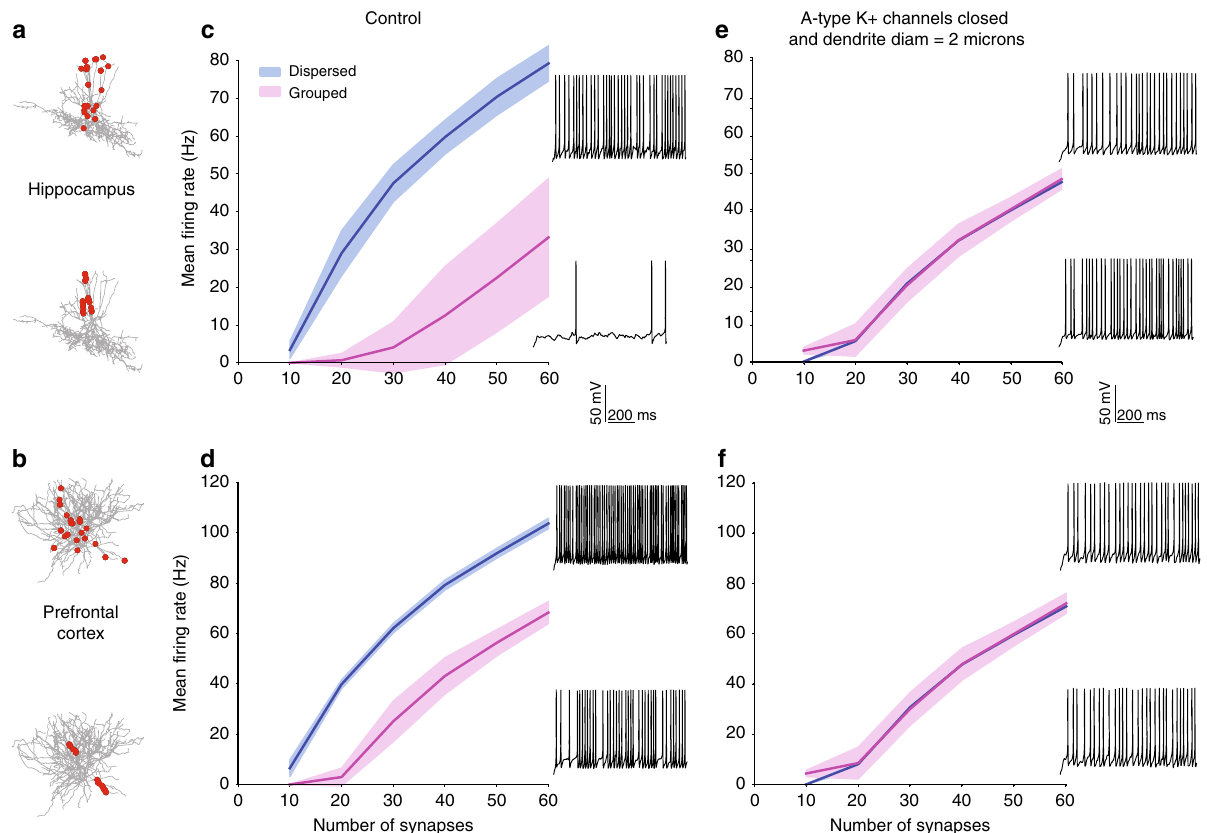
Fig. 4 Effect of bimodal dendritic integration on neuronal fi ring. Firing rate responses (in Hz) from one hippocampal ( a , c ) and one PFC ( b , d ) model cell, in response to stimulation of increasing numbers of synapses (10 – 60) that are either randomly distributed throughout the entire dendritic tree (blue) or grouped within a few dendritic branches (pink). Synapses are stimulated with a 50 Hz Poisson spike train. In both cases, dispersed activation leads to higher fi ring rates. e , f Same as in c , d with dendritic diameter set to 2 μ m and removal of A-type dendritic channels. Firing rates are indistinguishable between grouped and dispersed activation patterns. Insets depict representative traces from dispersed (top) and grouped (bottom) activation of 30 synapses. Red dots in a , b , show the synaptic allocation